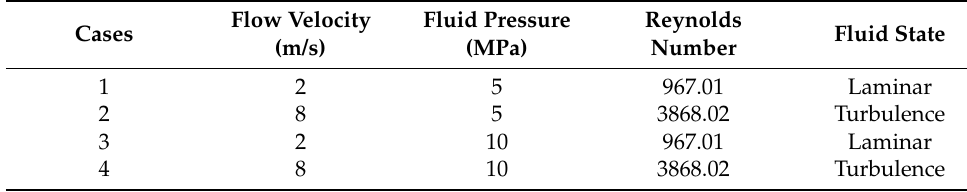
Figure 7. Schematic of the verification system. Table 2. Detailed calculation parameters for four cases.